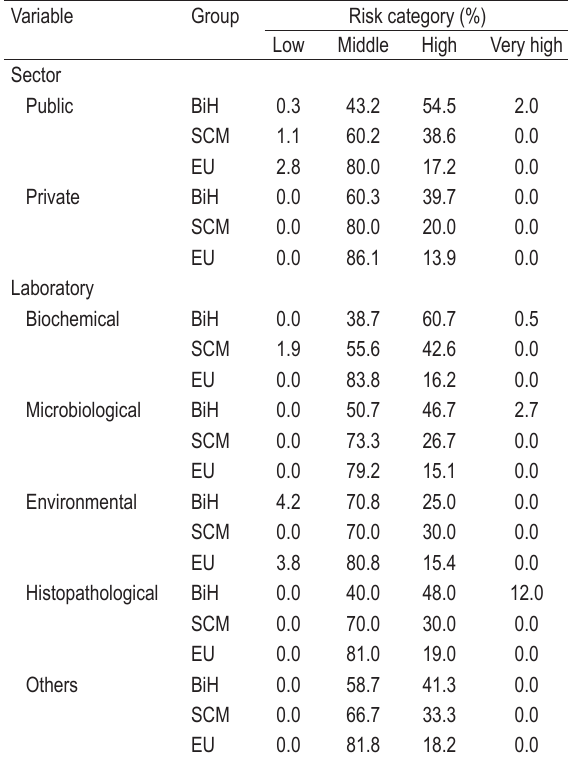
TABLE 5. Categorization of occupational risk by sector and type